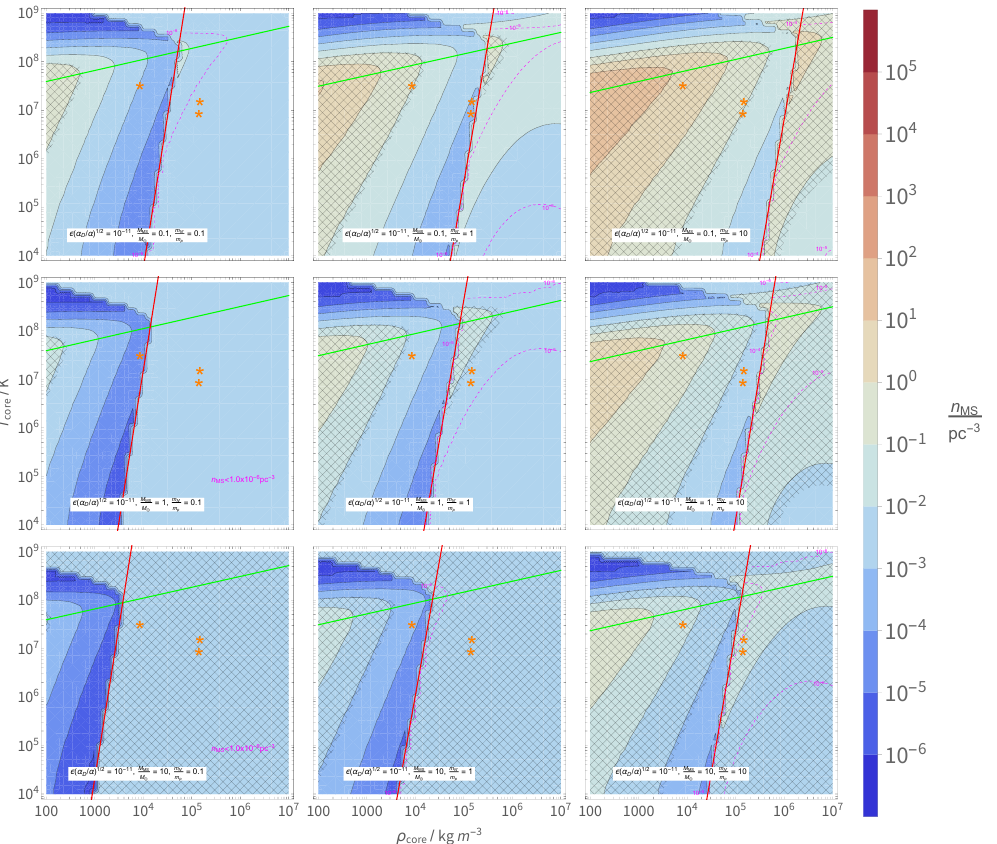
p α D /α em = 10 − 11 .